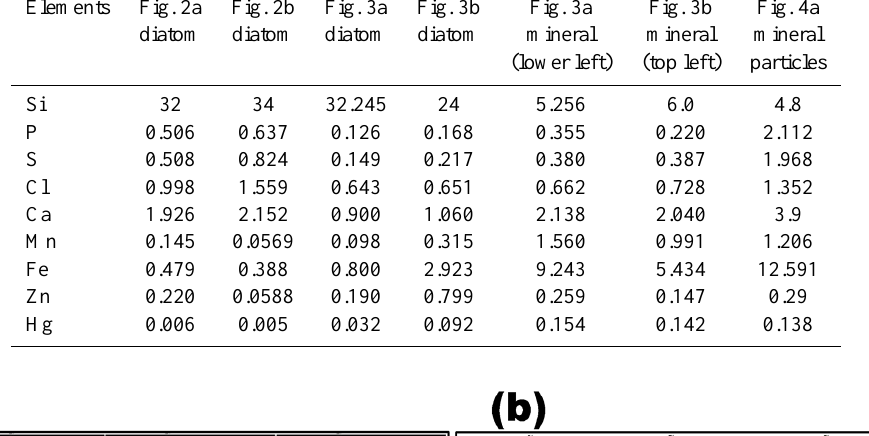
Table 1. The average elemental compositions (µgcm − 2 ) on the entire diatom and selected mineral particles determined by XRF in Figs. 2–4. Elements